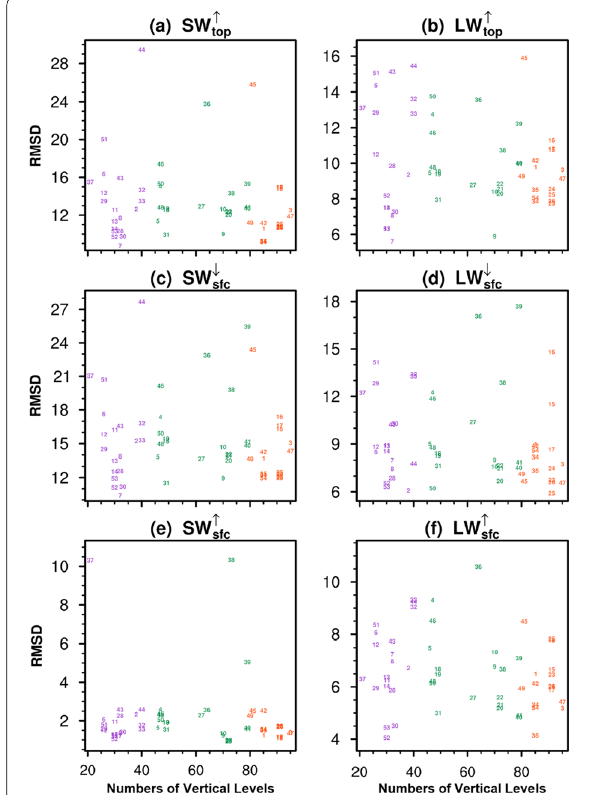
Fig. 9 Same as Fig. 1, but showing the dependence of RMSE on model vertical resolution. Models classified as high‑, medium‑ and low‑vertical resolution groups are highlighted in orange ( ≥ 80 levels; 19 models), green (41–79 levels; 19 models) and purple ( ≤ 40 levels; 16 models), respectively. All radiative fluxes are under all‑sky condition and are averaged over the global tropical ocean from 30° S to 30°